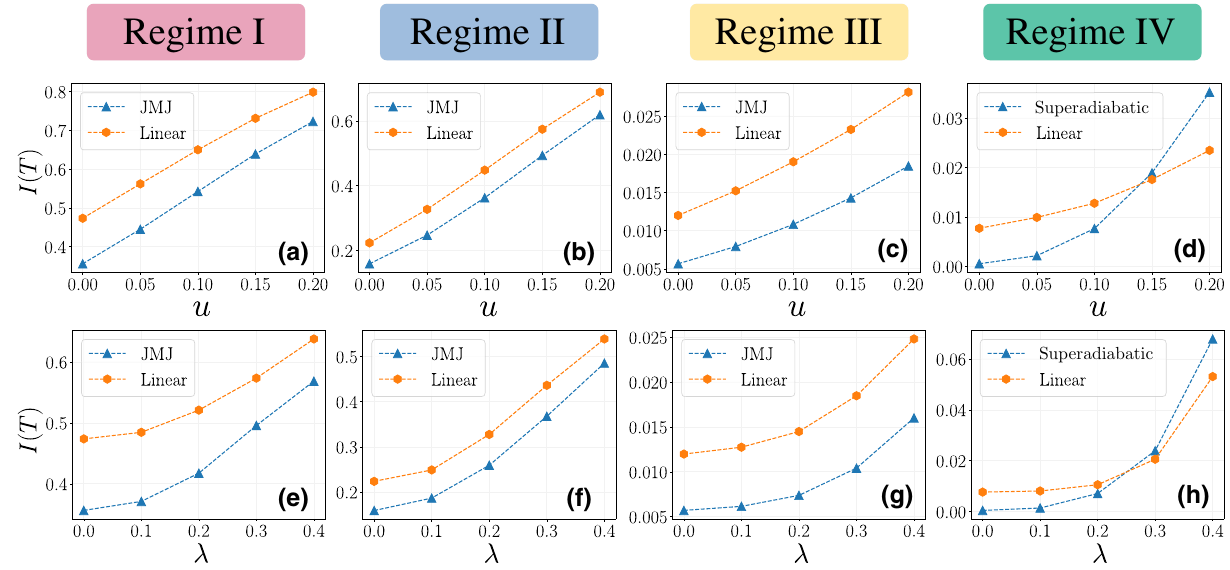
FIG. 15. Overview of simulation results of running the optimal protocols obtained in the clean noninteracting system in a system with interactions (top row) or disorder (bottom row) in all four regimes. In all regimes the infidelity increases with disorder strength λ and also with interaction strength u . The parameters for these simulations are the same as in Fig. 2 in the main text and the disorder averaging is done over 500 disorder